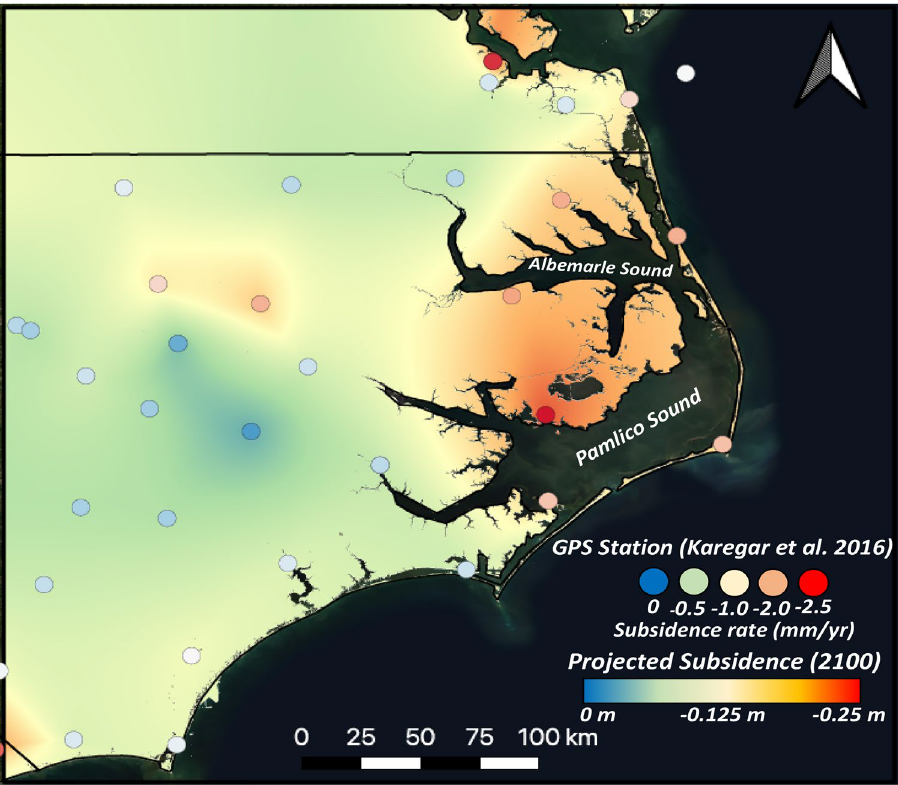
Figure 2. Annual subsidence rates and GPS recording stations, from 2 , and projections of total land surface elevation changes by 2100. Figure created in QGIS (Version 3.16, https:// qgis. org/ en/ site/ forus ers/ downl oad. html) using ESRI Satellite imagery as